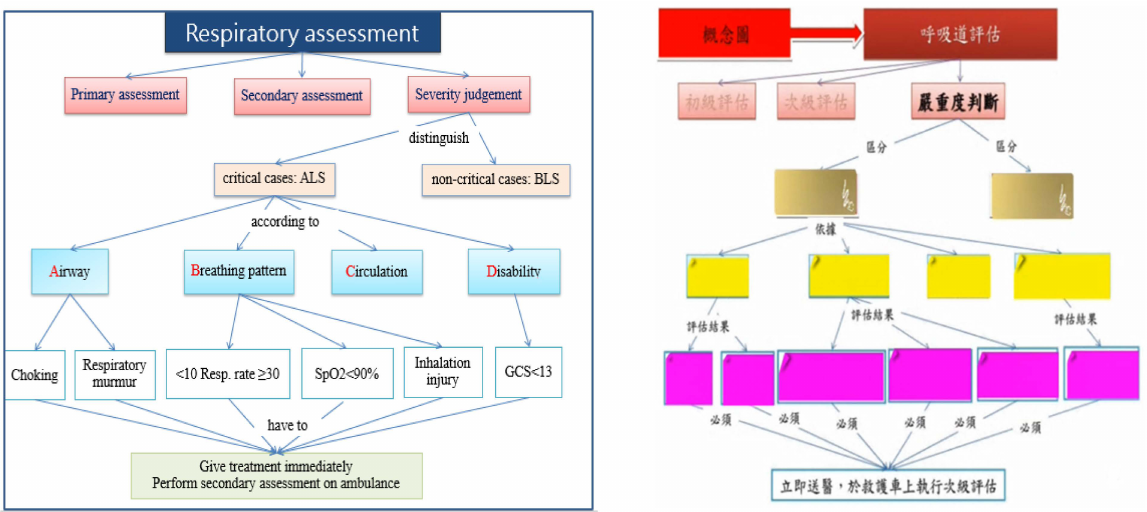
Figure 2. Concept map in the interactive eBook , right: before scratch-offs, left: after scratch-offs .